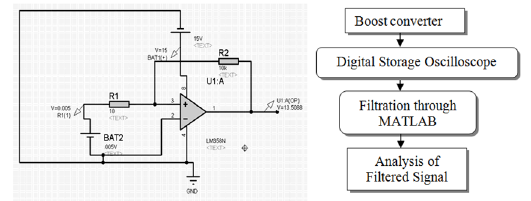
Figure 5. Bandpass filter circuit along with boost converter and Amplification scheme of captured signal.